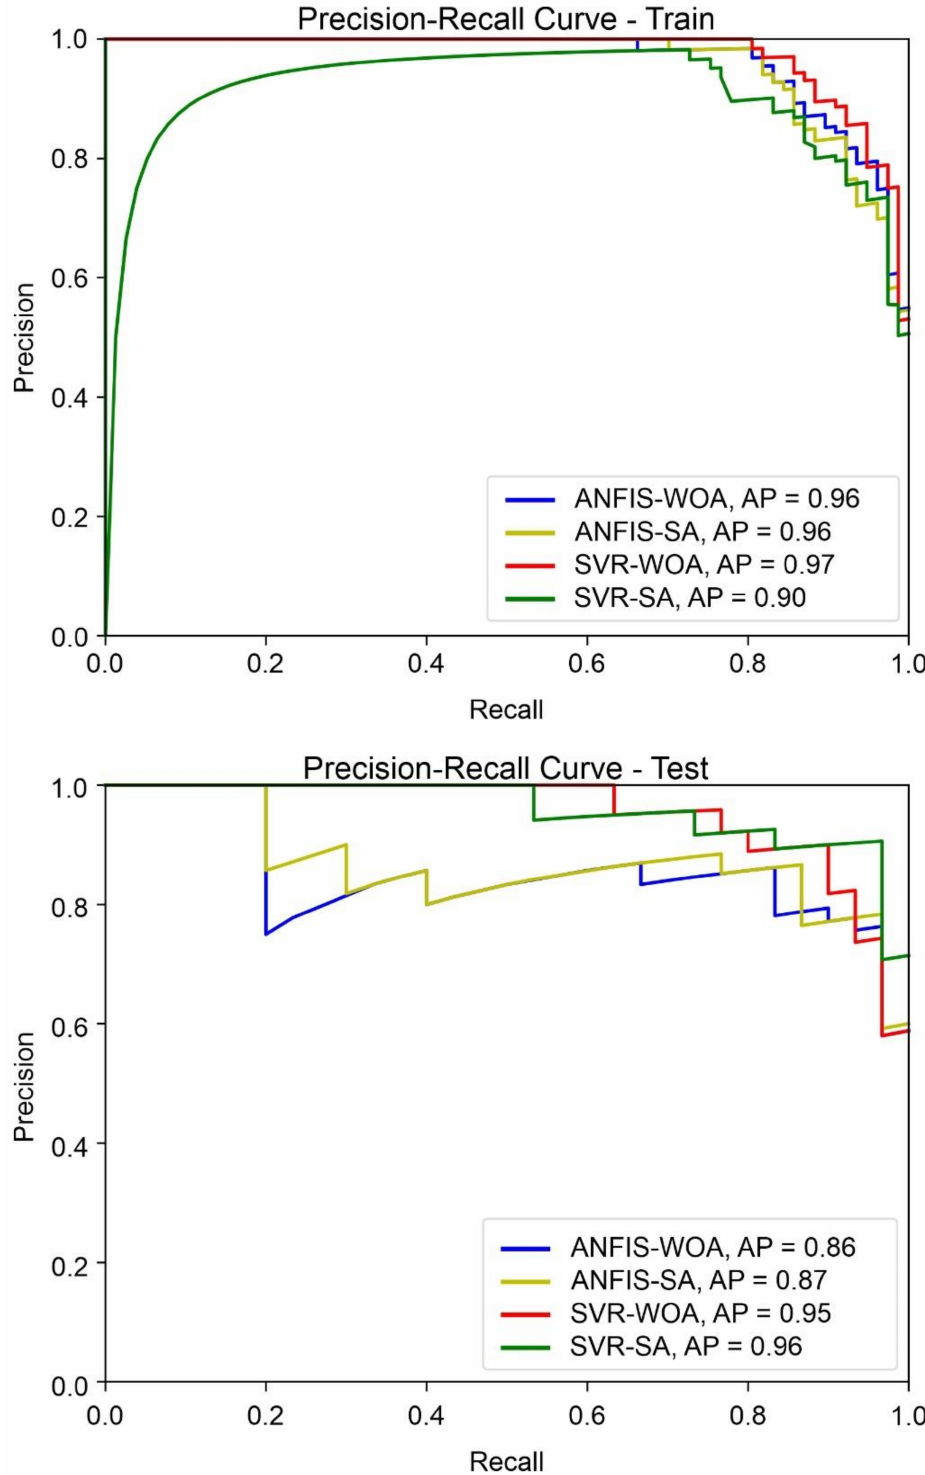
Figure 9. The Precision-Recall curves for four hybrid models in the training and testing